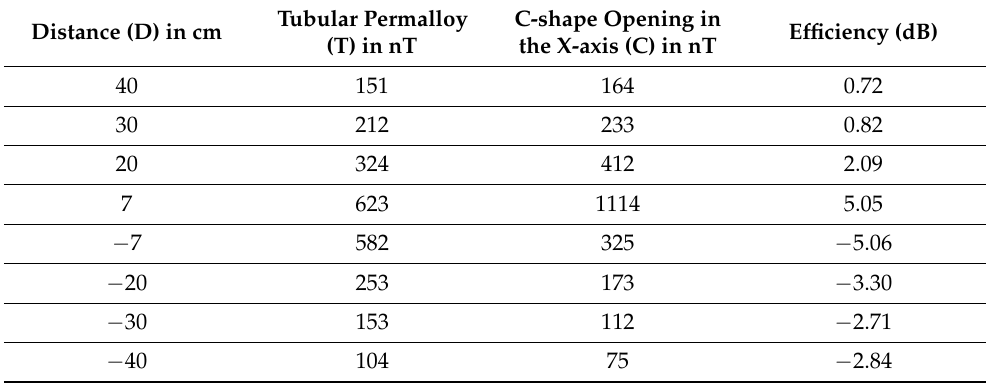
Table 3. Results of electromagnetic fields (peak value) in the C-shaped cylindrical device. Tubular Permalloy C-shape Opening in Efficiency (dB) Distance (D) in cm (T) in nT the X-axis (C) in nT 40 151 164 0.72 30 212 233 0.82 20 324 412 2.09 7 623 1114 5.05 − 7 582 325 − 5.06 − 20 253 173 − 3.30 − 30 153 112 − 2.71 − 40 104 75 −